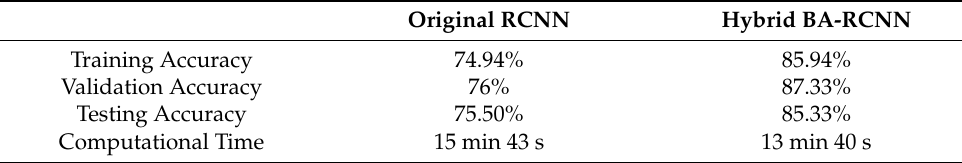
Table 11. Prediction accuracy and computational time for algorithms (final version).